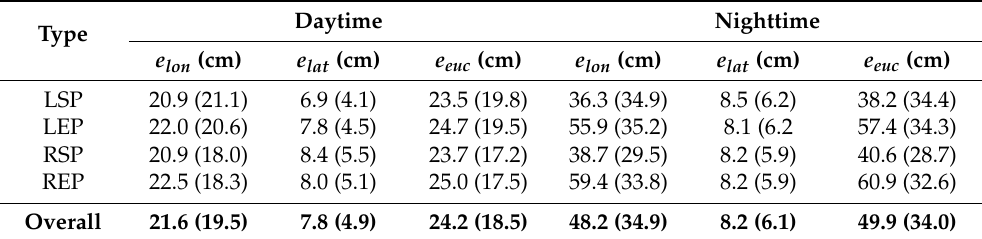
Figure 14. Images of lane endpoints in ( a ) daytime and ( b ) nighttime. Table 9. Position Accuracy Evaluation Result in Daytime and Nighttime. [Mean (Standard Deviation)].